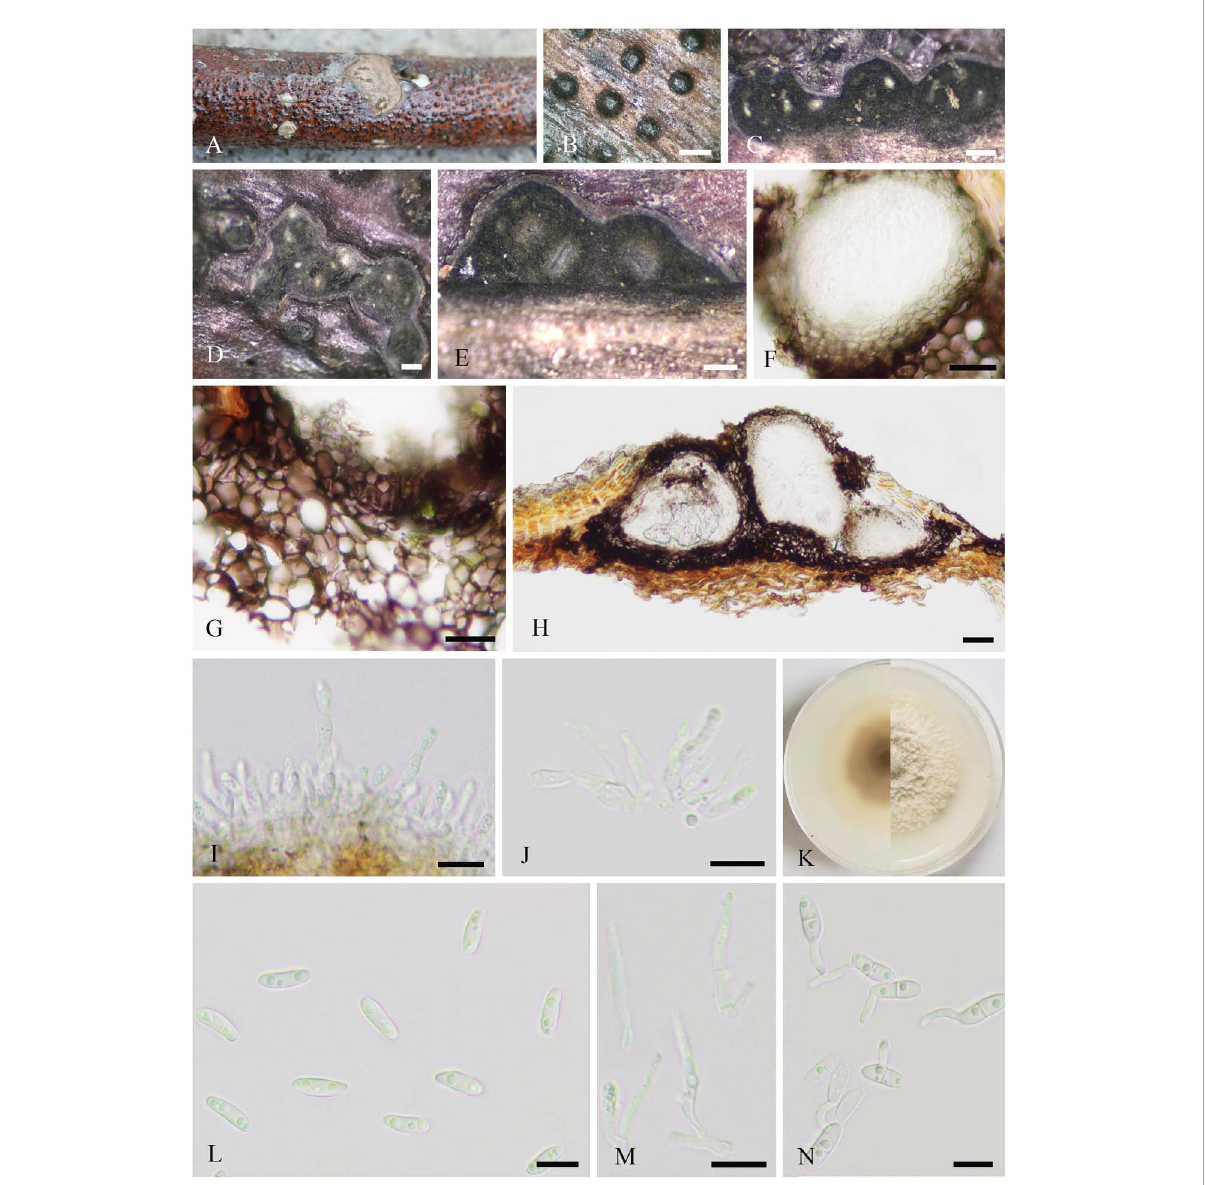
FIGURE5 Loculosulcatispora hongheensis (SICAU 22-0092). (A,B) Conidiomata on natural wood surface. (C–E) Vertical and transverse sections through conidiomata. (F,G) Conidioma wall. (H) Sections through conidiomata. (I,J) Conidiogenous cells and developing conidia. (K) Culture on PDA for 15 days. (L) Conidia. (M) Paraphyses. (N) Germinating conidia. Scale bars: (B) 500 µ m, (C–E) 200 µ m, (F–H) 20 µ m, and (I,J,L–N) 10 µ m.